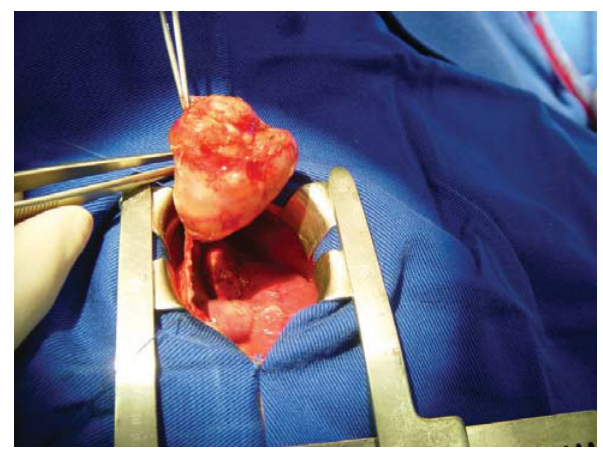
Fig. 3 – Massa tumoral após a